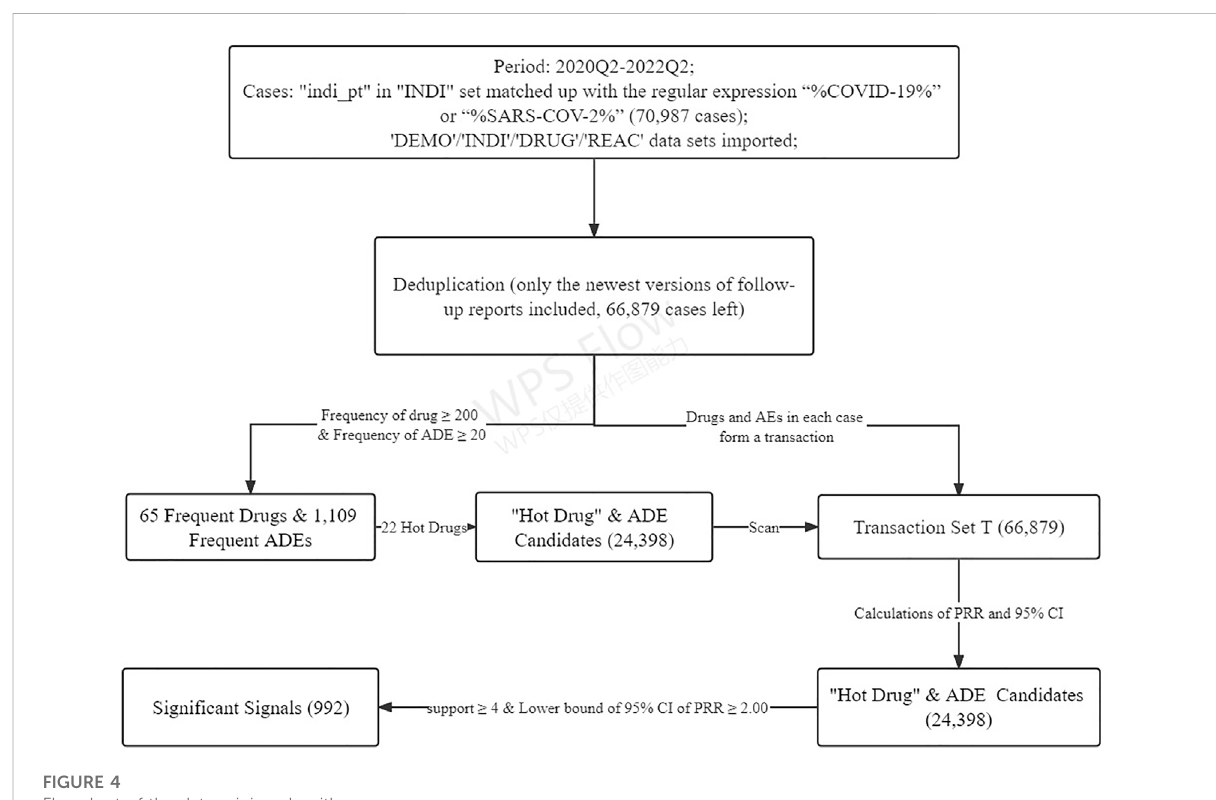
FIGURE 4 Flowchart of the data mining